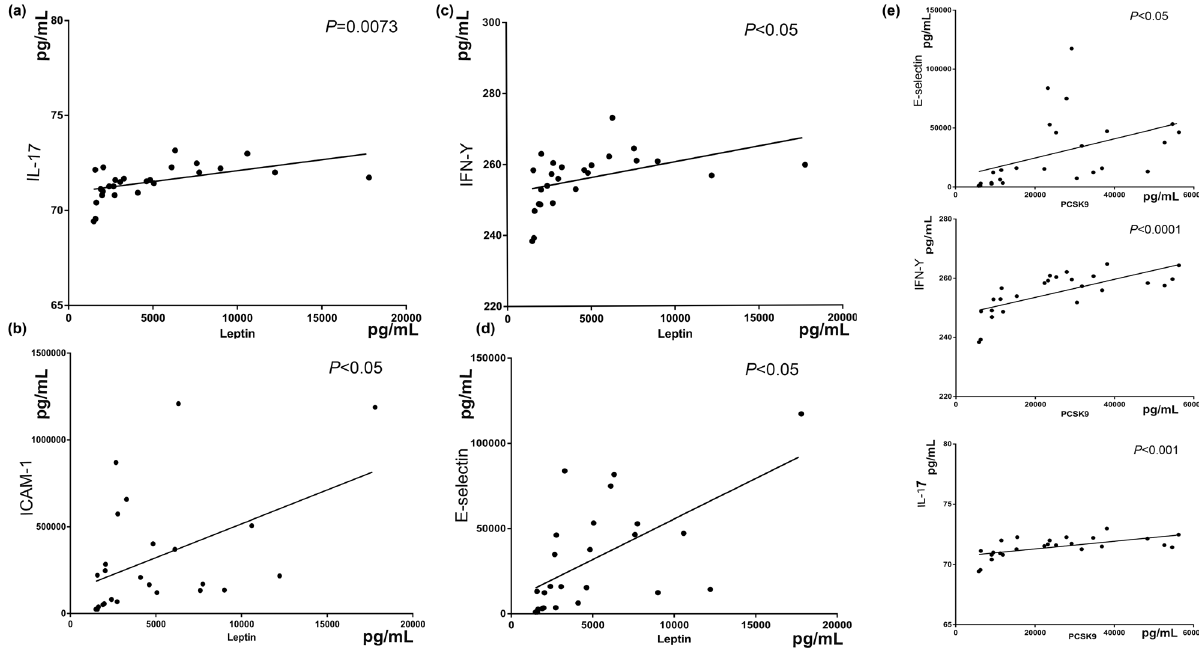
Figure 3: Signi fi cant relationship between leptin, PCSK9, and endothelial cell adhesion factors was observed. Correlation lines between leptin and IL - 17 ( a ) , IFN - γ ( b ) , ICAM - 1 ( c ) , E - selectin ( d ) ; and Correlation lines between IL - 17, E - selectin, IFN - γ , and PCSK9 ( e )